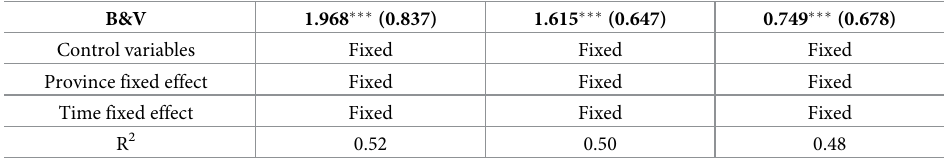
Table 6. The regression result of removing designated poor